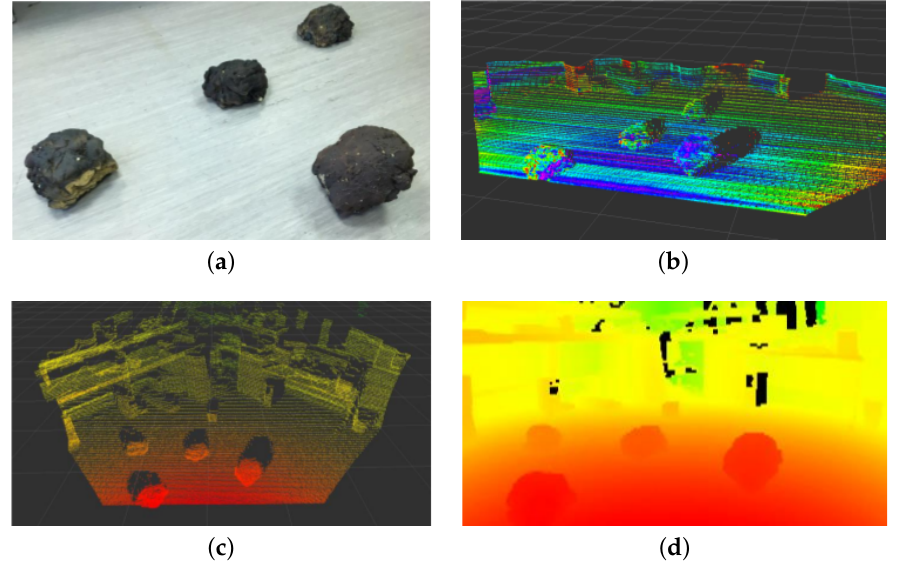
Figure 5. Example illustration of a scattering of LIDAR points ( b ) of a flat surface with rock boulders ( a ); point cloud ( c ) and depth map ( d